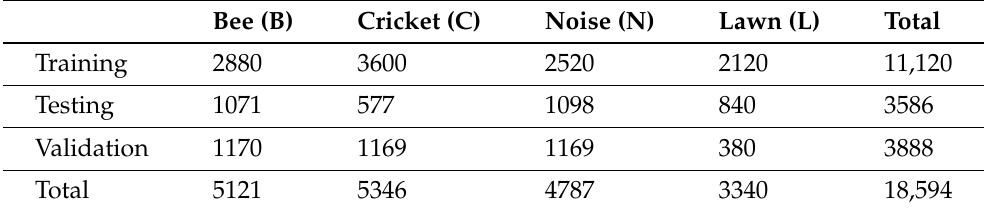
Table 3. Audio sample distribution in BUZZ3 (first three columns) and BUZZ4 (first four columns). Bee (B) Cricket